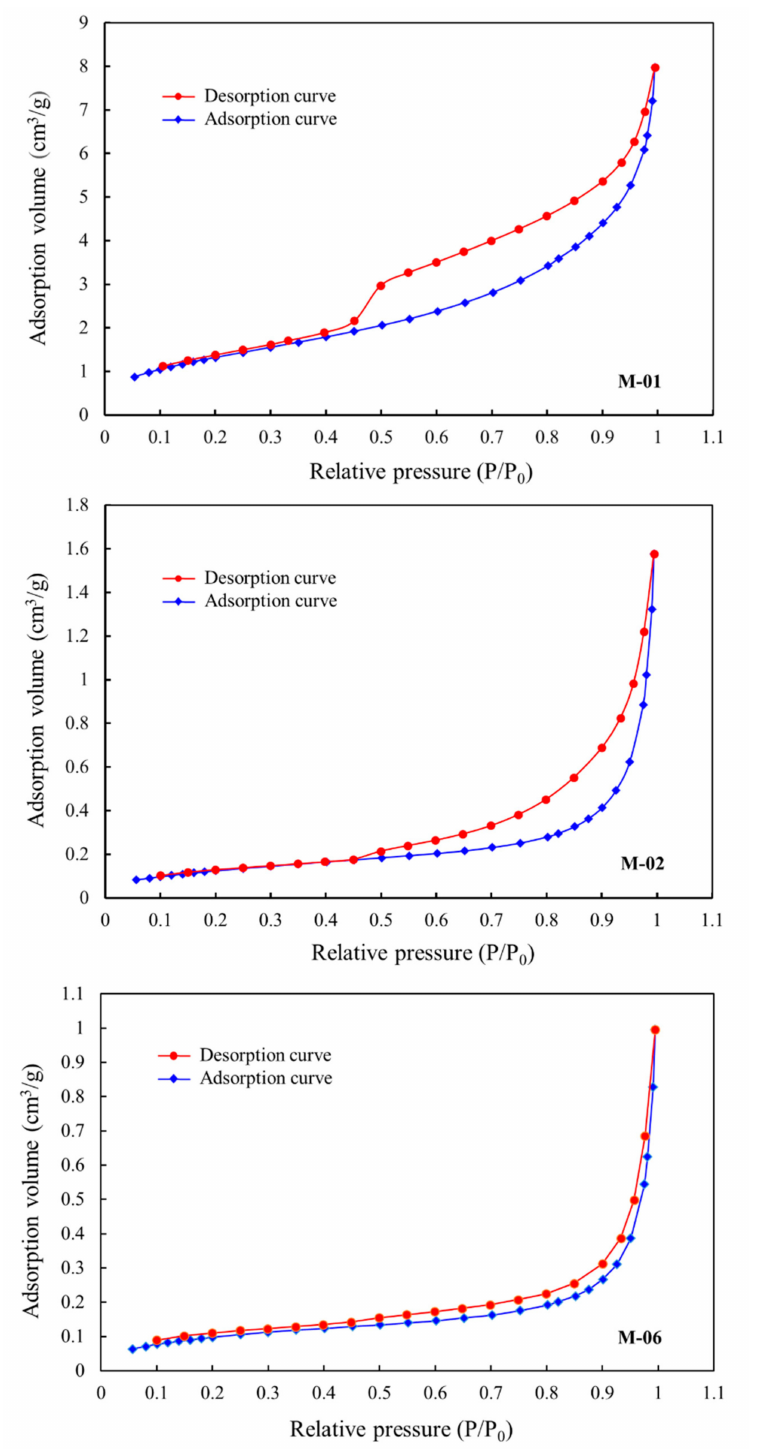
Figure 7. Low-temperature N 2 adsorption / desorption curves of